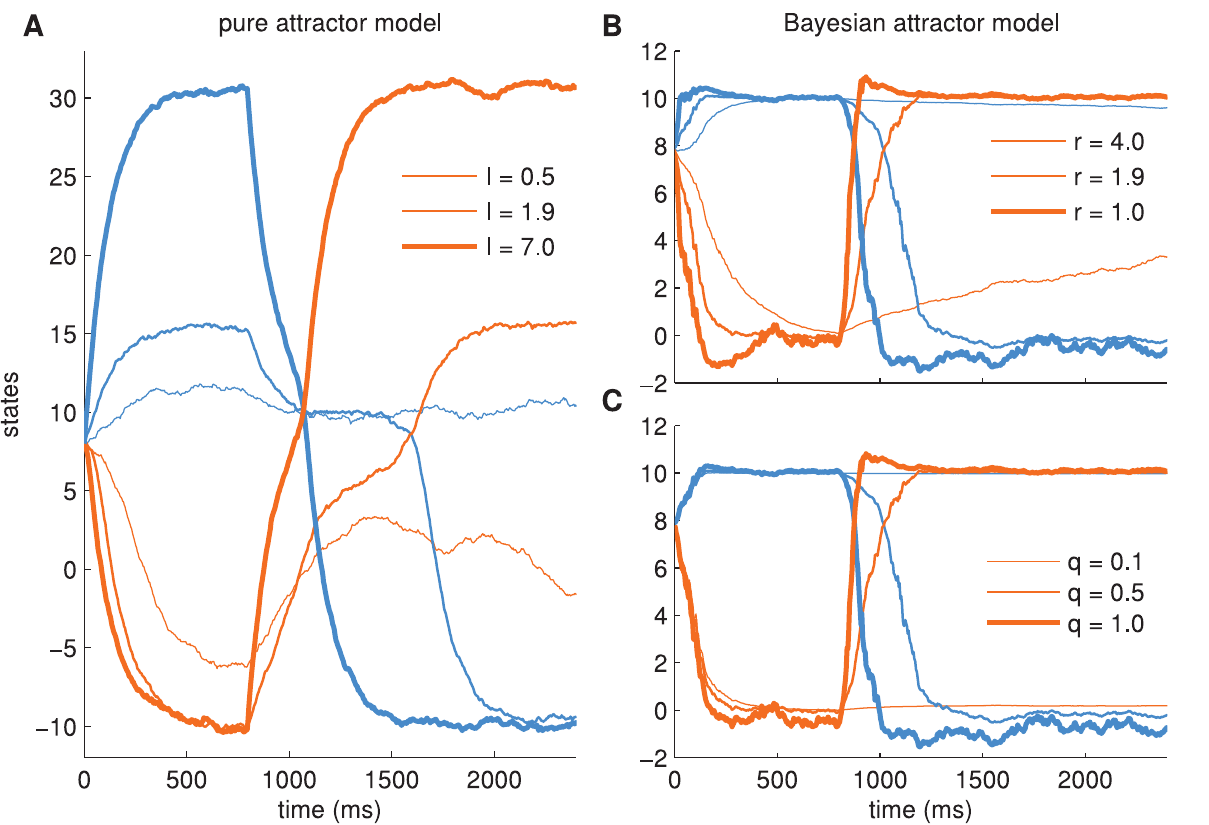
Fig 9. Evolution of decision state for pure attractor model (left) and Bayesian attractor model (right) for different input strengths or different uncertainty parameters, respectively. There are two alternatives indicated by blue (alternative 1) and orange (alternative 2). Thinner lines indicate smaller stimulus strength. For the first 800ms, input reflecting alternative 1 was shown, with a switch to input caused by alternative 2 at 800ms. (A) In the pure attractor model speed and accuracy of initial and re-decisions is controlled by the input which we set to I t = [ Δ tI + v t ,0], if alternative 1 is correct, and I t = [0, Δ tI + v t ], if alternative 2 is correct ( v t * N (0,0.2 2 )). We varied the value of I as indicated in the plot legend. If I is large, i.e., the task is easy, initial decisions and switches are fast (thick lines). The position of the fixed point, to which the dynamics converges, depends strongly on I . (B, C): In the Bayesian attractor model timing and accuracy of initial decisions and re-decisions depend on the uncertainties in the model, but, critically, the location of the fixed points of the dynamics remain the same for different uncertainties. B and C share the same observations with noise level s = 1. In B: q = 0.5. In C: r = 1.9.